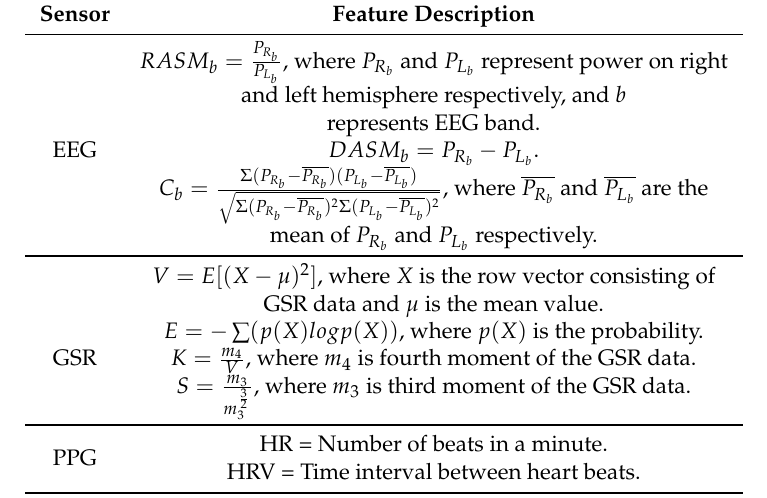
Table 3. Description of extracted features in this study for emotion recognition. Sensor Feature Description P Rb RASM b = , where P R and P L represent power on P Lb b b